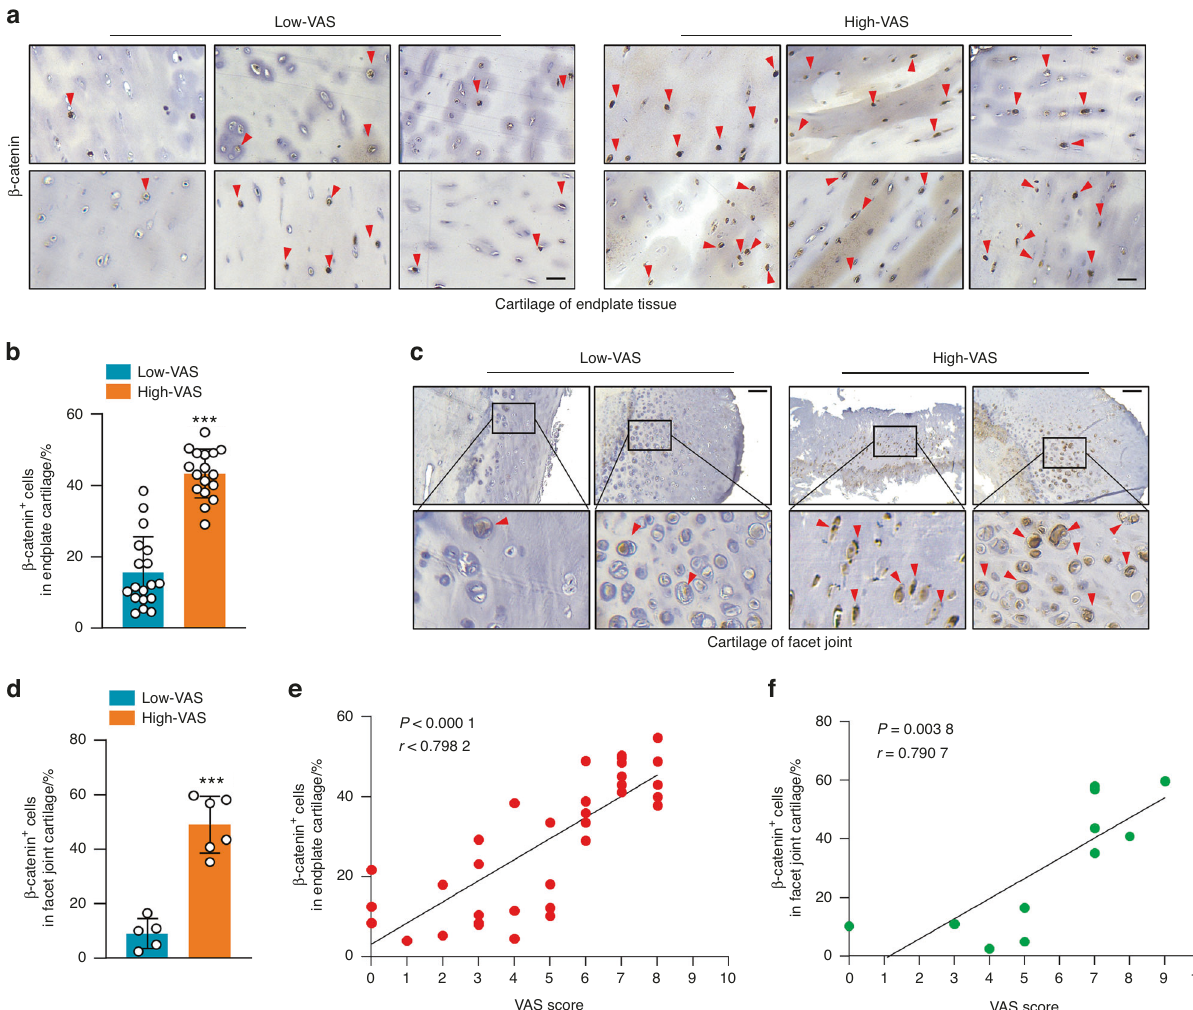
Fig. 1 Upregulation of β -catenin protein levels in patients with disc degeneration and facet joint osteoarthritis. a , b Representative immunohistochemistry (IHC) images ( a ) showing the expression of β -catenin + cells ( b ) in endplate cartilage in the high-VAS and low-VAS groups (scale bar 50 μ m). (High-VAS group: n = 17, Low-VAS group: n = 18). c , d Representative IHC images ( c ) showing the expression of β -catenin + cells ( d ) in facet joint cartilage in the high-VAS and low-VAS groups (scale bar, 100 μ m). (High-VAS group: n = 6, Low-VAS group: n = 5). e Correlation analysis between the number of β -catenin + cells in endplate cartilage and VAS scores in individuals with disc degeneration. ( n = 35). f Correlation analysis between the number of β -catenin + cells in facet joint cartilage and VAS scores in individuals with disc degeneration. ( n = 11). * P < 0.05; ** P < 0.01; *** P < 0.001. Data are represented as the mean ± SD. Two-tailed unpaired Student ’ s t test analysis (b and d) and Spearman ’ s correlation analysis ( e , f